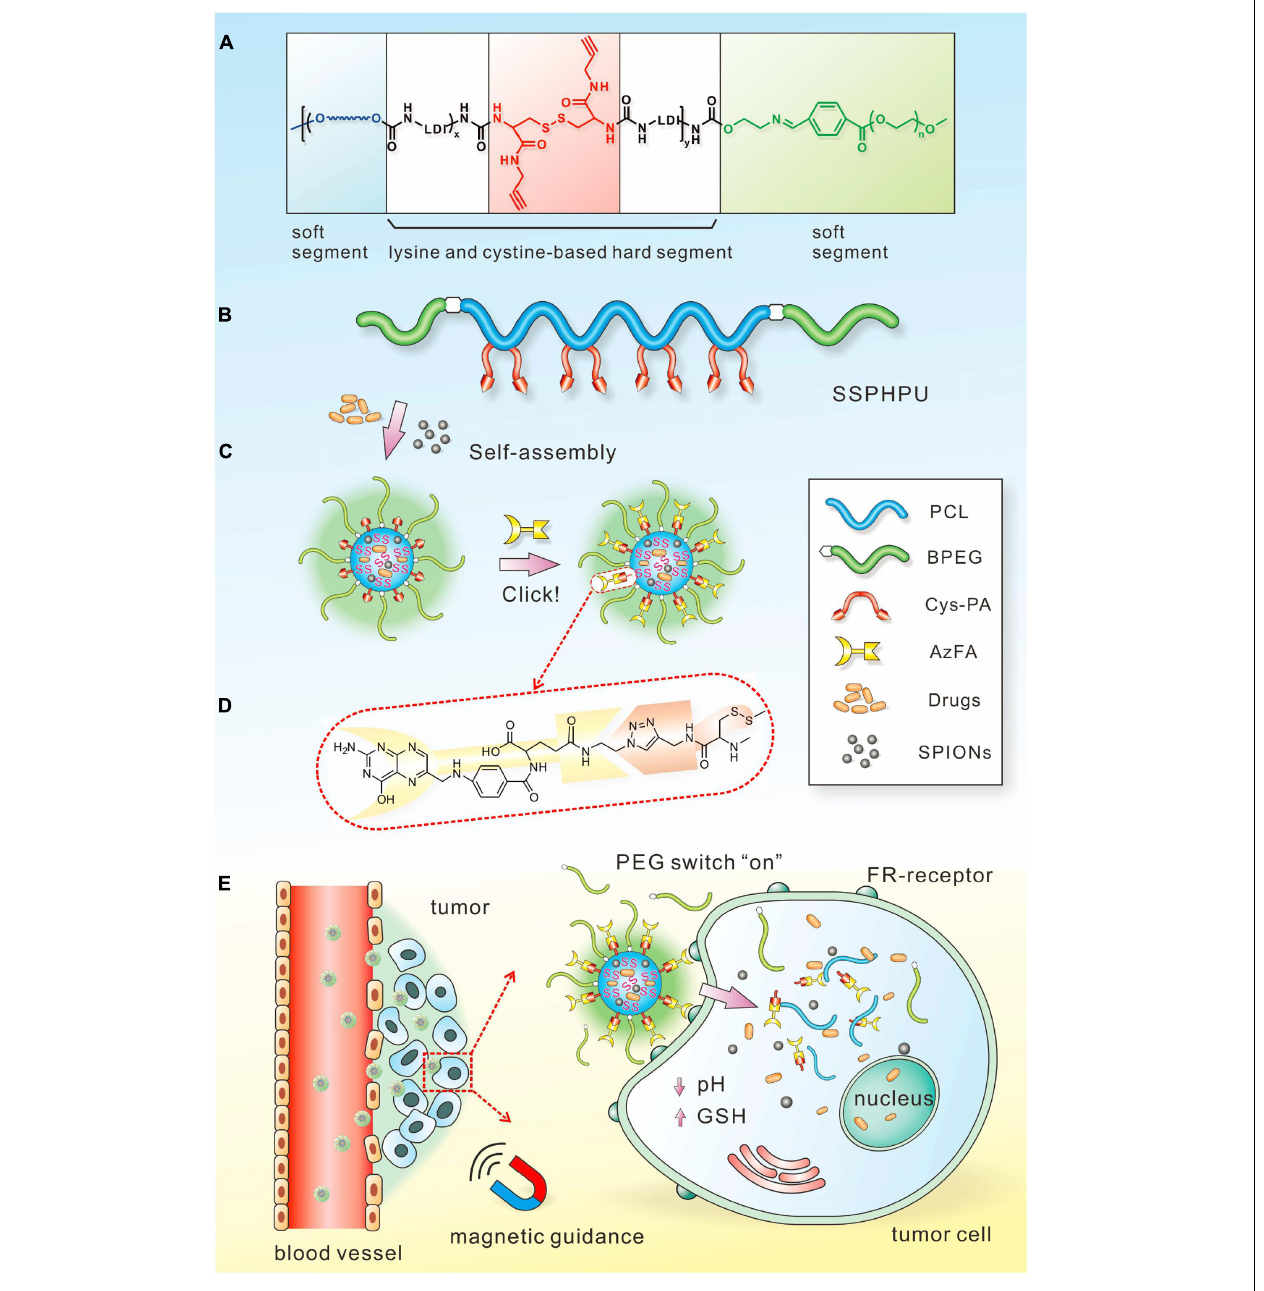
FIGURE 9 | Schematic illustration of the magnetic field-responsive polymer micelles. Schematic chemical structure (A) and molecular architecture (B) of clickable multiblock polyurethanes (MPUs). (C) Self-assembly of MPU micelles and post-conjugation of folic acid via click chemistry. (D) Schematic illustration of FA residues on the interface of polymer micelles. (E) Illustration of magnetic-guided and PEG-switched targeting and release properties of MPU nanocarriers. Reprinted from Jing Wei, Xiaoyu Shuai, Rui Wang, et al. Clickable and imageable multiblock polymer micelles with magnetically guided and PEG-switched targeting and release property for precise tumor theranostics. Biomaterials. 2017;145:138–53. With permission from reference (Wei et al.,